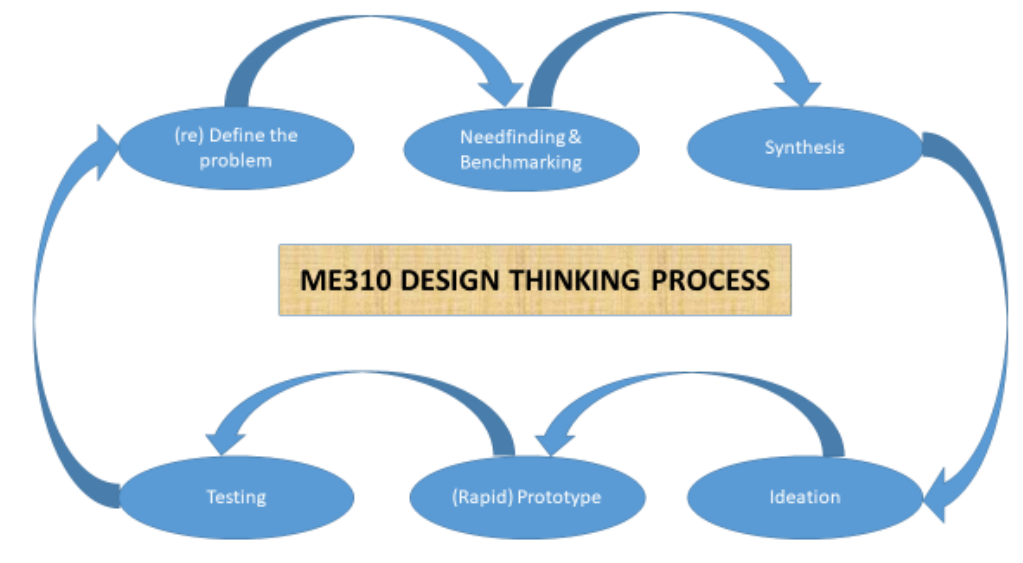
Figure 2. Stanford ME310 model. Adapted from [70].